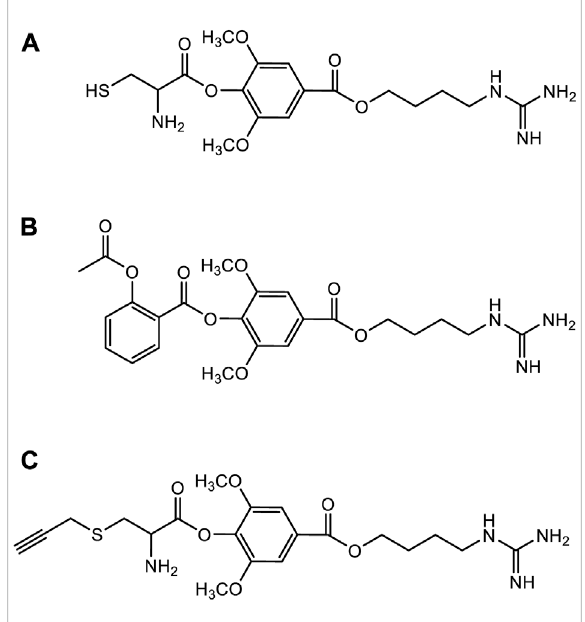
FIGURE 8 The structural modi fi cation of leonurine. (A) The chemical structures of leonurine-cysteine. (B) The chemical structures of leonurine-aspirin. (C) The chemical structures of